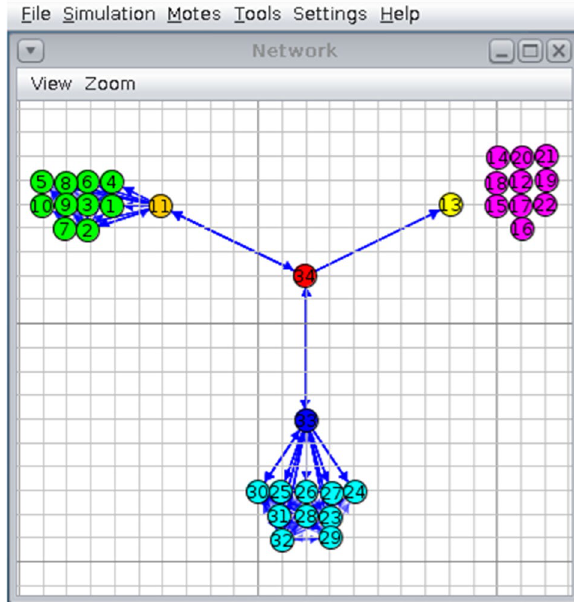
Fig. 10 Modified smart home with linear arrangement